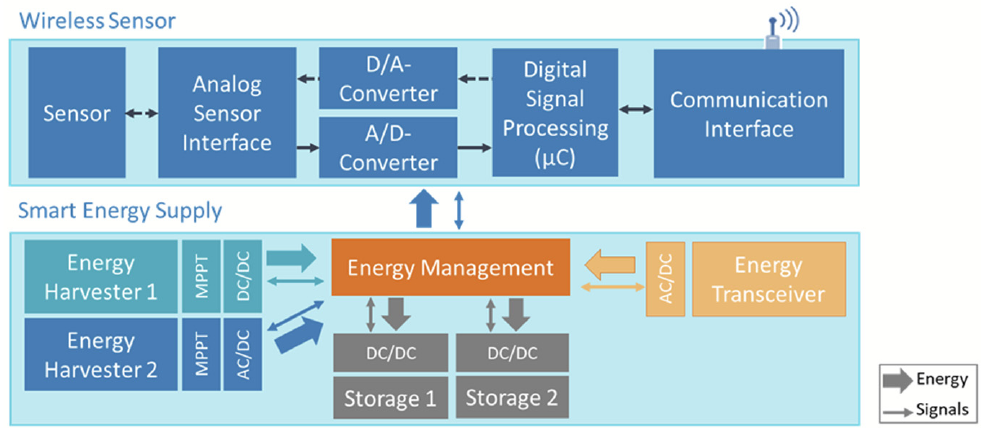
Figure 2. Generalized energy supply strategies of wireless sensor nodes based on energy harvesting, hybrid energy harvesting and wireless energy transfer.